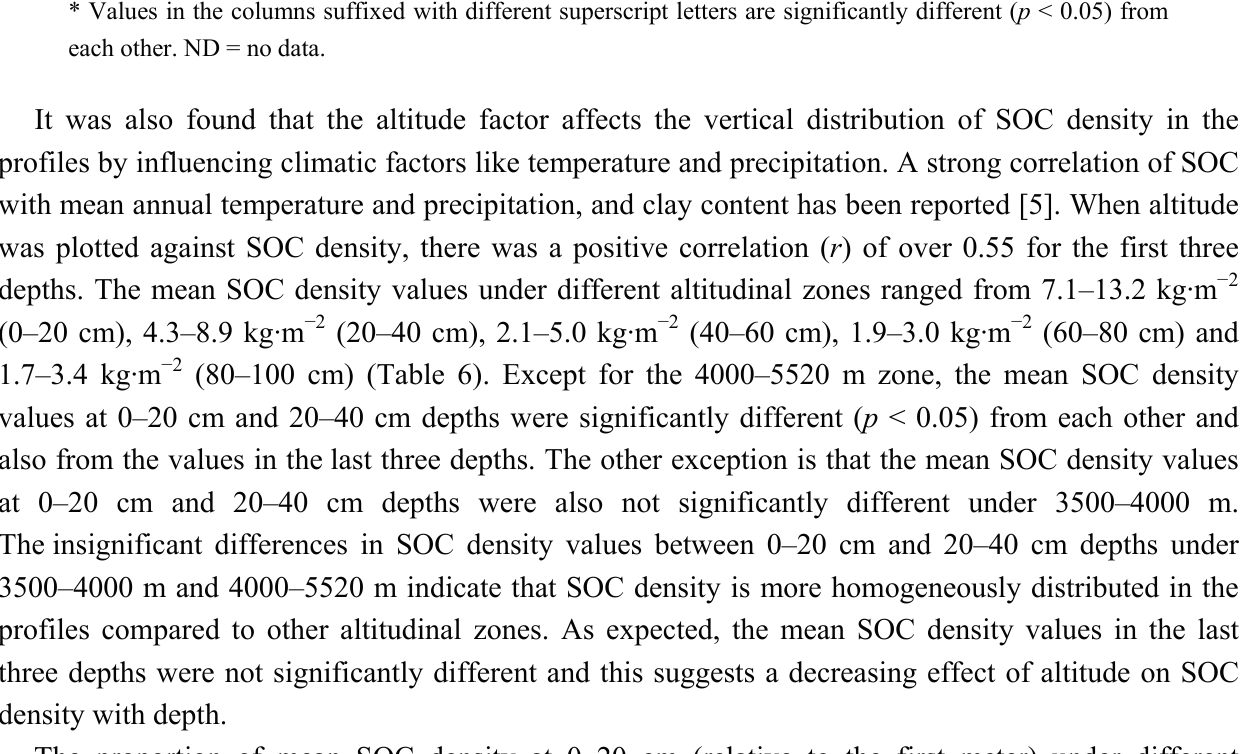
2.14 ± 0.31 c 1.73 ± 0.30 c 2.22 ± 0.53 c 3.35 ± 0.71 c ND * Values in the columns suffixed with different superscript letters are significantly different ( p < 0.05) from each other. ND = no